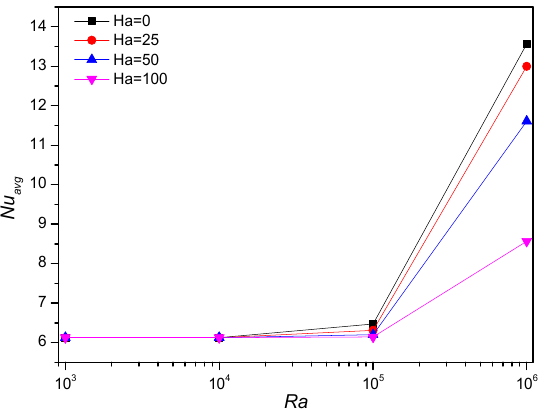
Figure 5. Average Nusselt number (Nu ave ) as a function of Rayleigh number (Ra) at various values of Hartmann number (Ha). Da = 0.01, 𝜙 = 0.02, and 𝜀 p = 0.4.